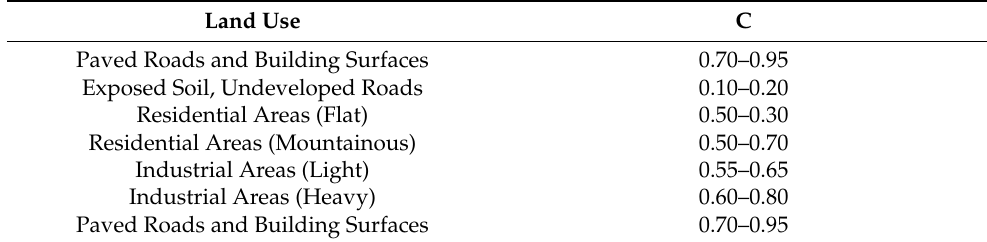
Table 4. Rational Method Runoff Coefficient Values